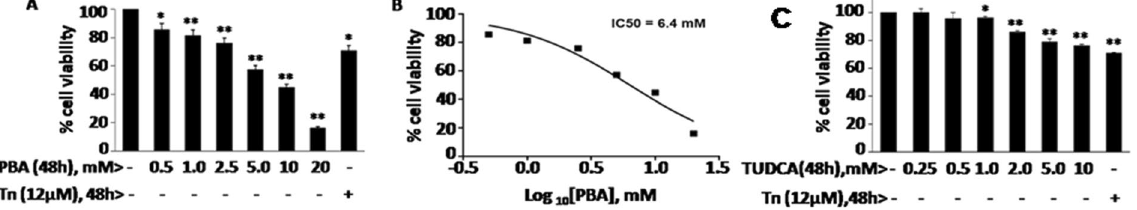
Figure 4. HepG2 cell viability in the presence of PBA or TUDCA: HepG2 cell viability was measured by MTT assay as described in ‘Materials and Methods’. Panel A: Cells were treated with different concentrations of PBA (0.5–20 mM) or with 12 µ M tunicamycin for 48 h. Panel B: IC50 value for PBA as determined by using GraphPad Prism 6 software. Panel C: Cell viability in the presence of different concentrations of TUDCA (0.25– 10 mM) or 12 µ M tunicamycin for 48 h. Data shown are mean ± SD, (n = 3). The asterisks represent statistically